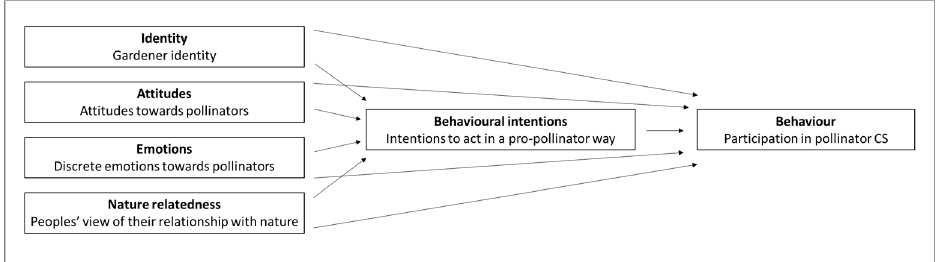
Figure 1. Adapted framework showing the relationship between the concepts identity, attitudes, emotions, nature relatedness, behavioural intentions and behaviour [25,30,37].